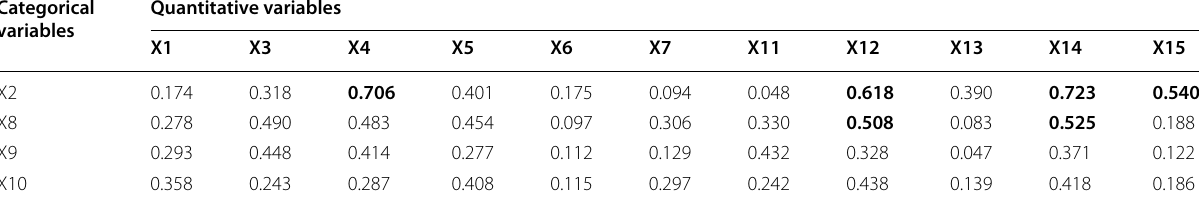
Table 5 Eta correlation coefficients